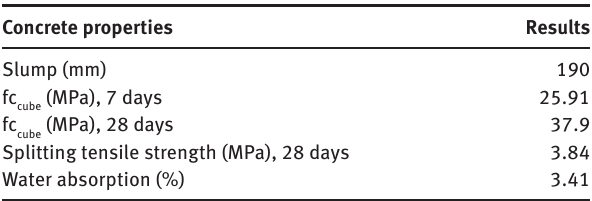
Table 4: Properties of C30-type conventional concrete produced in this